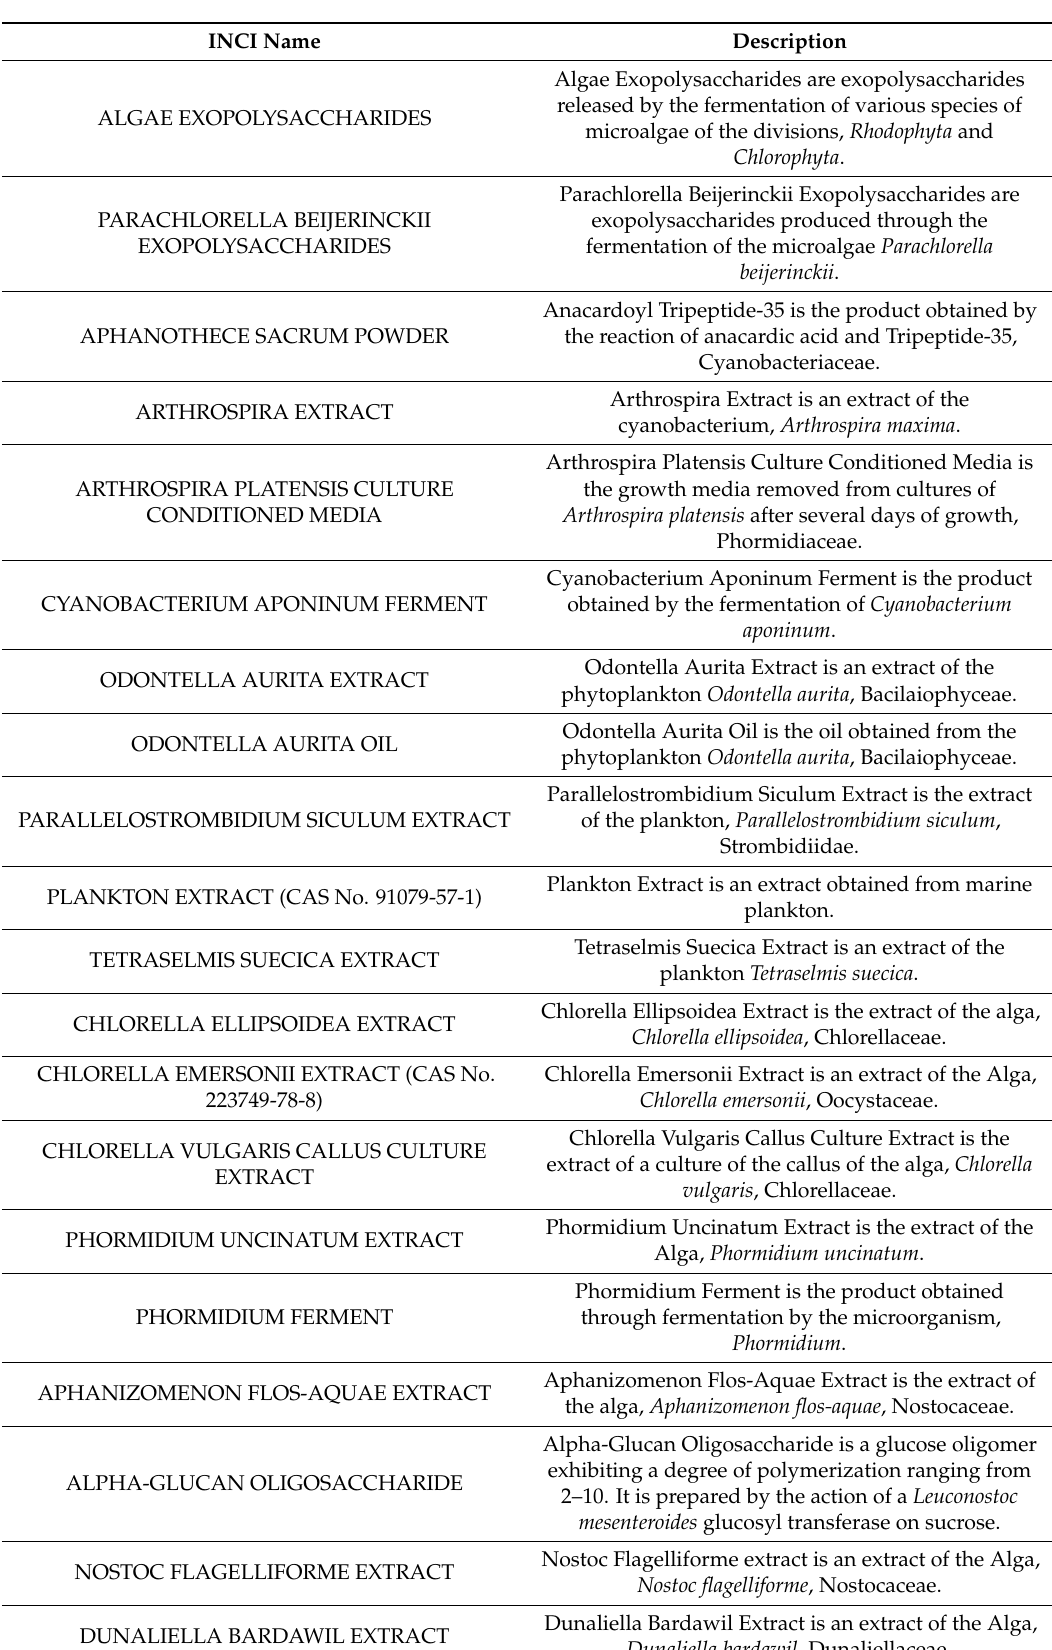
Table 2. INCI names (International Nomenclature of Cosmetic Ingredients) and CAS number (Chemical Abstracts Service) of cosmetic substances and ingredients on CosIng (Cosmetic Ingredient